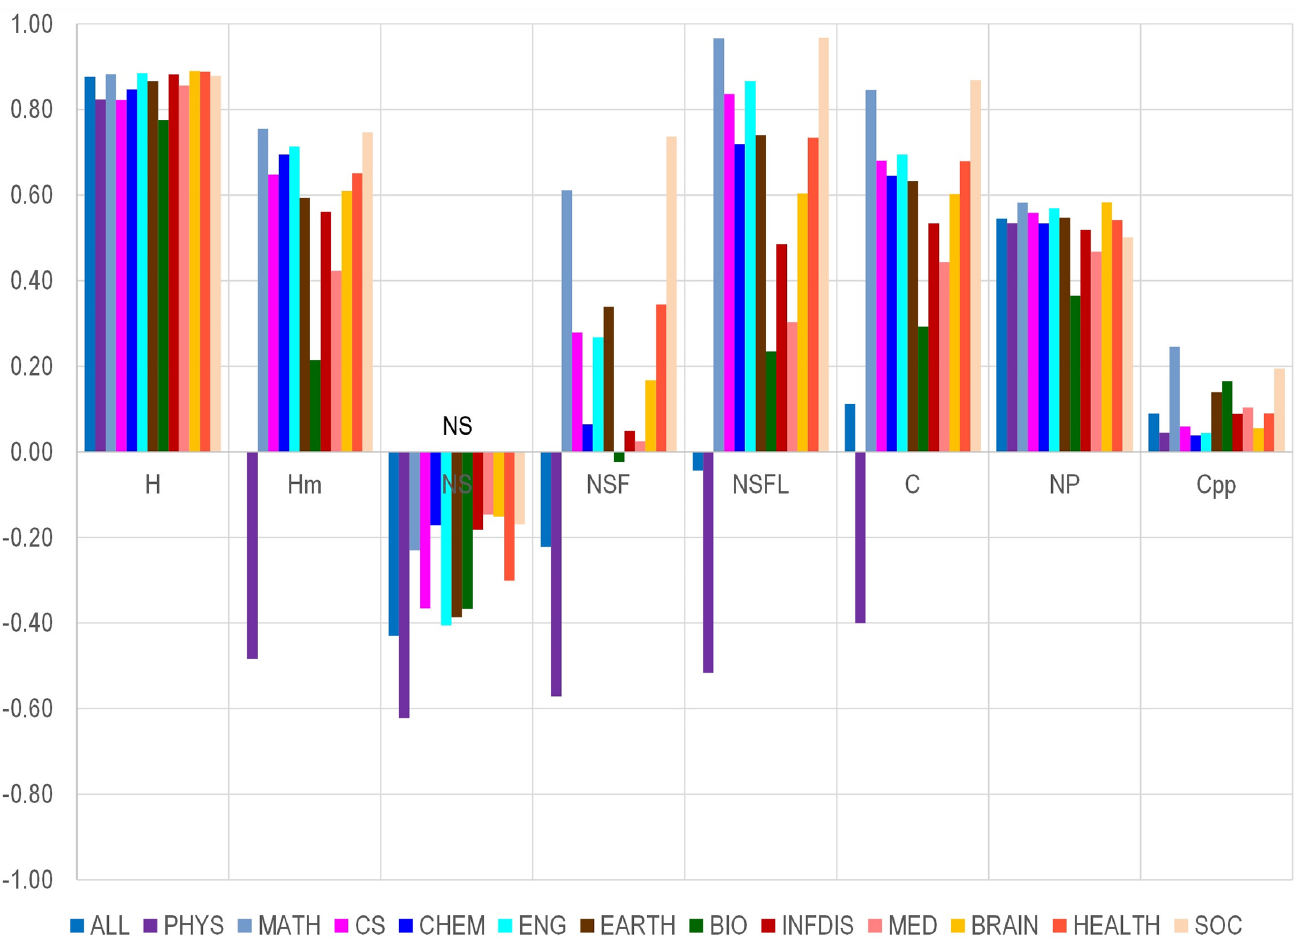
Fig 1. Correlation between number of citations and various citation indicators and other metrics in each of 12 different scientific fields. Abbreviations: PHYS, physics; MATH, mathematics; CS, computer science; CHEM, chemistry; ENG, engineering; EARTH, earth sciences;